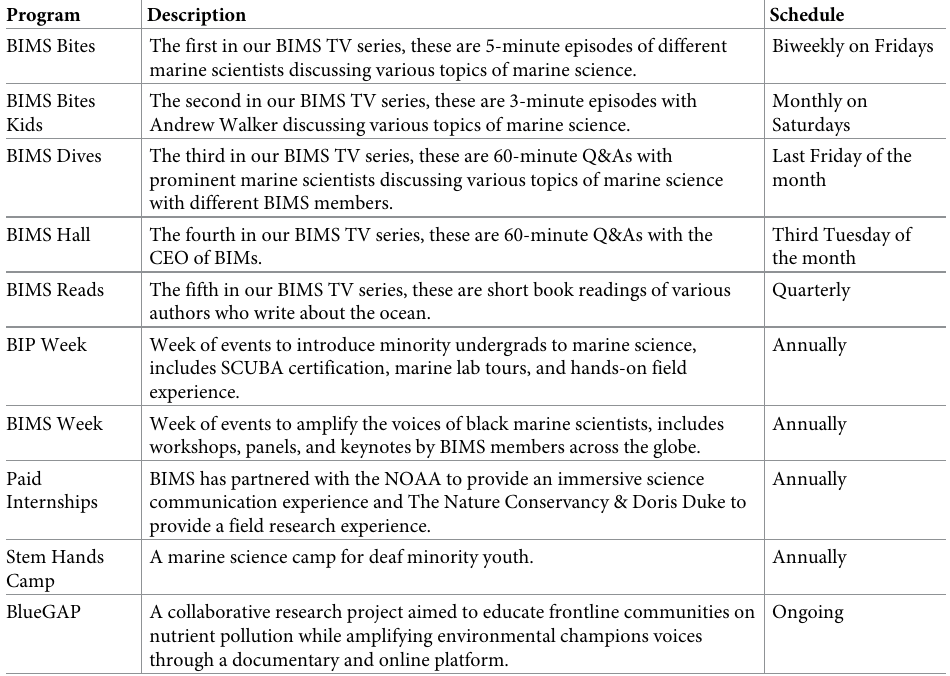
Table 1. Black in Marine Science